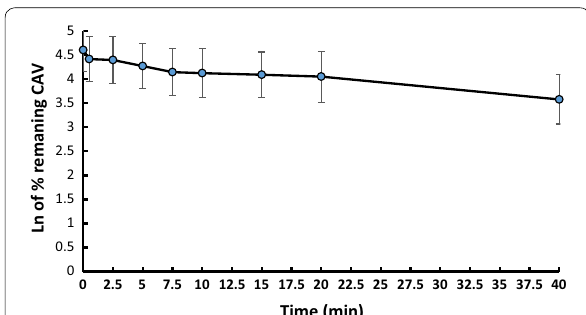
Fig. 5 The metabolic stability profile of conivaptan after incubation with RLMs. Metabolic reaction was stopped at different time points